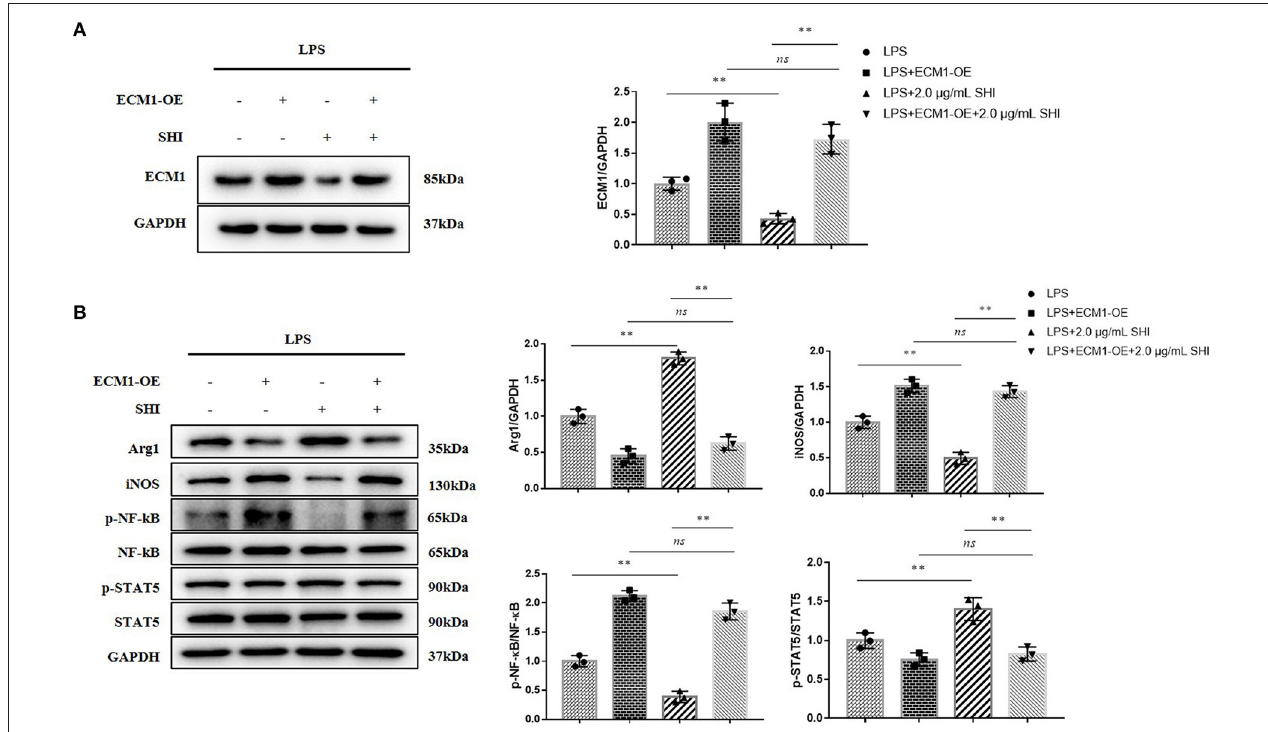
FIGURE 6 | ECM1 overexpression reduces the inhibition of inflammation by Shionone. (A) Western blot analyses of expression of ECM1 and histogram of relative expression of each protein ( n = 3). (B) Western blot analyses of expressions of Arg1, iNOS, p-NF- κ B, NF- κ B, p-STAT5, and STAT5 in LPS-stimulated RAW264.7 cells and histogram of relative expression of each protein ( n = 3). Results are expressed as ± SD for independent experiments, ** p < 0.01 are considered to be significantly different. ns = not statistically